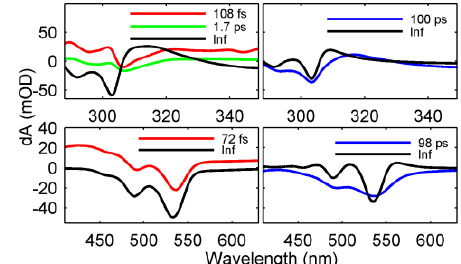
Fig. 1. TA of [Fe II (bpy) 3 ](PF 6 ) 2 in the UV and visible.